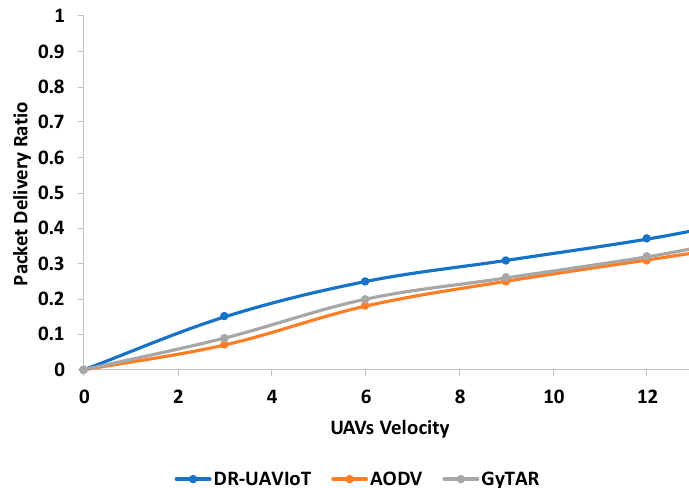
Figure 7. Packet Delivery Ratio in the Presence of Different UAVs Nodes Velocity.